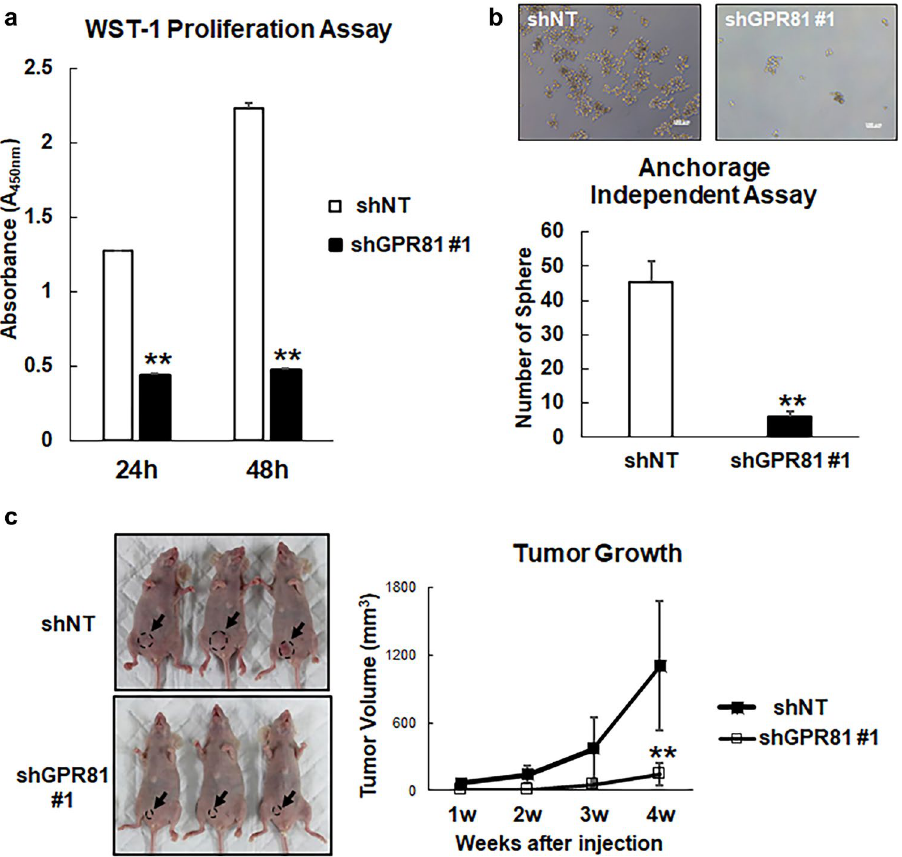
Figure 3. Decrease in cell proliferation and tumor growth of shGPR81 MDA-MB-231 cells. ( a ) ShNT and shGPR81 #1 cells were cultured in 96 well plates, and cell proliferation was determined using the WST-1 Proliferation Assay Kit ( n = 5/group). **p < 0.01 (vs. shNT cells); Student’s t -test. ( b ) Anchorage-independent cell growth of shNT and shGPR81 cells. ShNT and shGPR81 cells were cultured in EZ-BindShut microplates for 7 days, and the number of spheres were counted using a light microscope. The upper panel shows representative micrographs of spheres generated from shNT and shGPR81 cells. Scale bars 100 μm (top). Sphere-forming potential of shNT and shGPR81 cells (mean ± s.d.; n = 3). **p < 0.01 (vs. shNT cells); Student’s t -test (bottom). ( c ) Representative images of MDA-MB-231 shNT and shGPR81 #1 xenografts at 4 weeks after tumor cell injection (left). Tumor volumes of shNT and shGPR81 #1 xenografts were measured over a period of 4 weeks after cell injection (right; n = 5/group). **p < 0.01 (vs. shNT cells); Student’s t